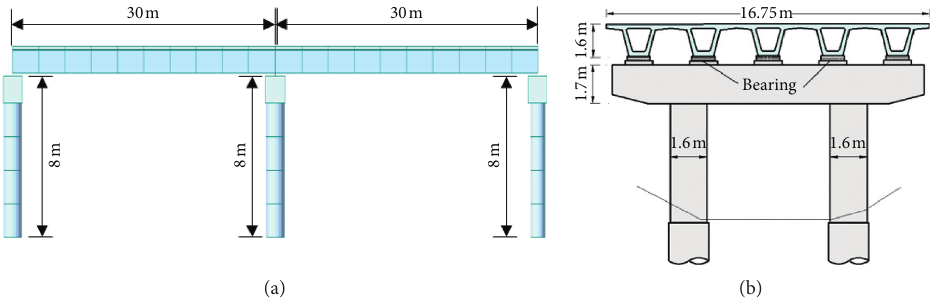
Figure 2: Simplified bridge geometry: (a) longitudinal view; (b) transverse view. Table 1: Parameters of high-damping rubber bearings. Bearing size (mm)